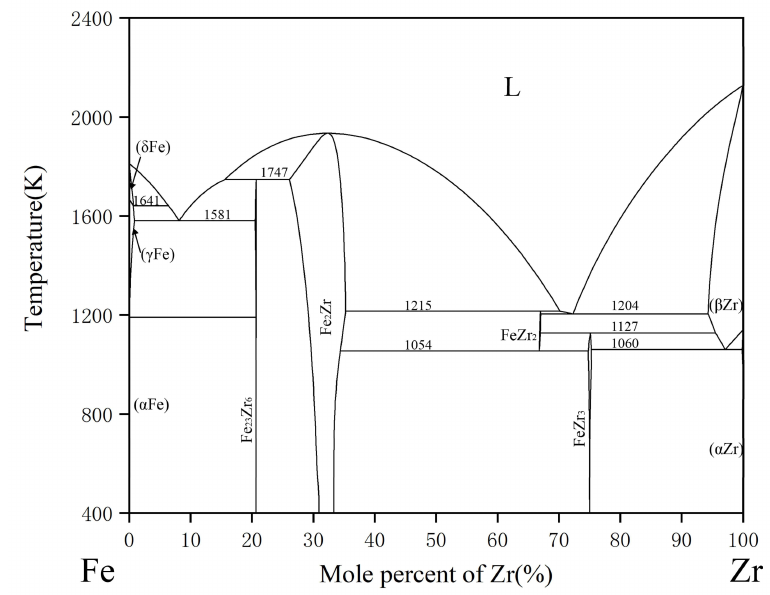
Figure 1. The calculated Fe-Zr phase diagram based on the work of Lu et al. [30]. Domagala et al. [31] reported the Fe-Y phase diagram for the first time in the whole composition range. Then, a thermodynamic assessment was carried out by Gschneider et al. [32] Recently, Zhang et al. studied the crystallography and thermodynamics of the compounds in the system, which provided a basis for further optimization of the Fe-Y system [33]. Figure 2 shows the Fe-Y phase diagram with four intermetallic compounds: Fe 17 Y 2 , Fe 23 Y 6 , Fe 3 Y and Fe 2 Y. Based on the previous research work mentioned above, Saenko et al. [34] reported the thermodynamic optimization of the Fe-Y binary system, as shown in Figure 2.